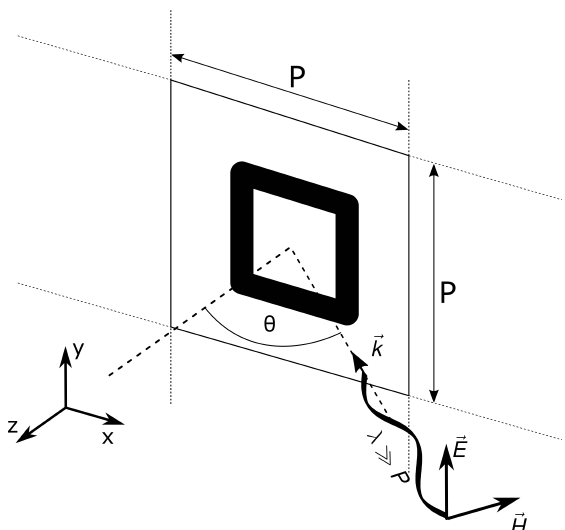
Figure 1. Unit cell geometry with obliquely-incident plane wave excitation. The image displays a TE-incident wave, with (cid:126) k residing in the xz plane. A TM-incident wave would have (cid:126) E and (cid:126) H swapped in this